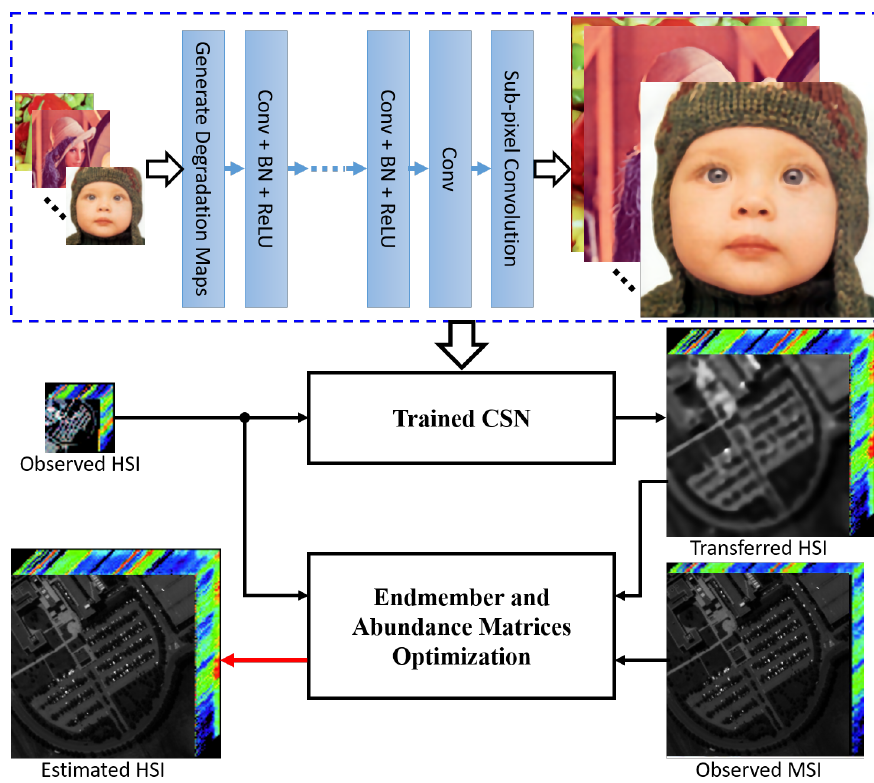
Figure 1. The flowchart of the proposed method. First, the Convolutional Super-Resolution Network (CSN) model parameters are learned on the low- and high-resolution natural images. Then, the transferred HSI is obtained by the trained CSN model with respect to the observed HSI. Finally, the endmember matrix and the abundance matrix of the estimated HSI are optimized by using the observed HSI, the observed Multispectral Image (MSI), and the transferred HSI. BN, Batch